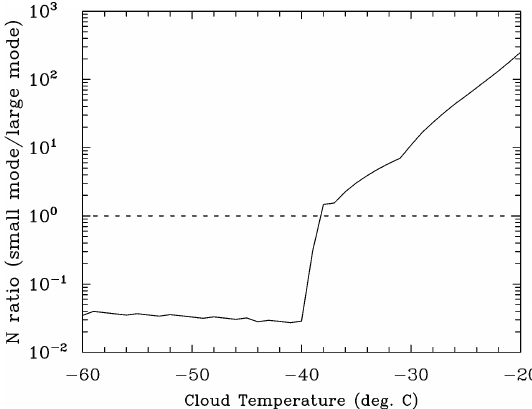
Fig. 10. Retrieval of PSD bimodality for the 5 August 2007 case study, based on the mean β eff values in Fig. 5b assuming all-ice conditions. Bimodality is evaluated using the N ratio (ice particle concentration of small mode / large mode) with N ratio ∼ 1 roughly separating unimodal from bimodal